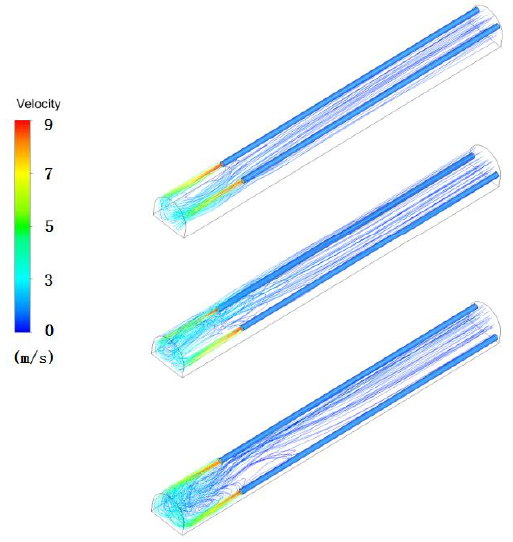
Figure 21. Models 4–6 speed streamline distribution.